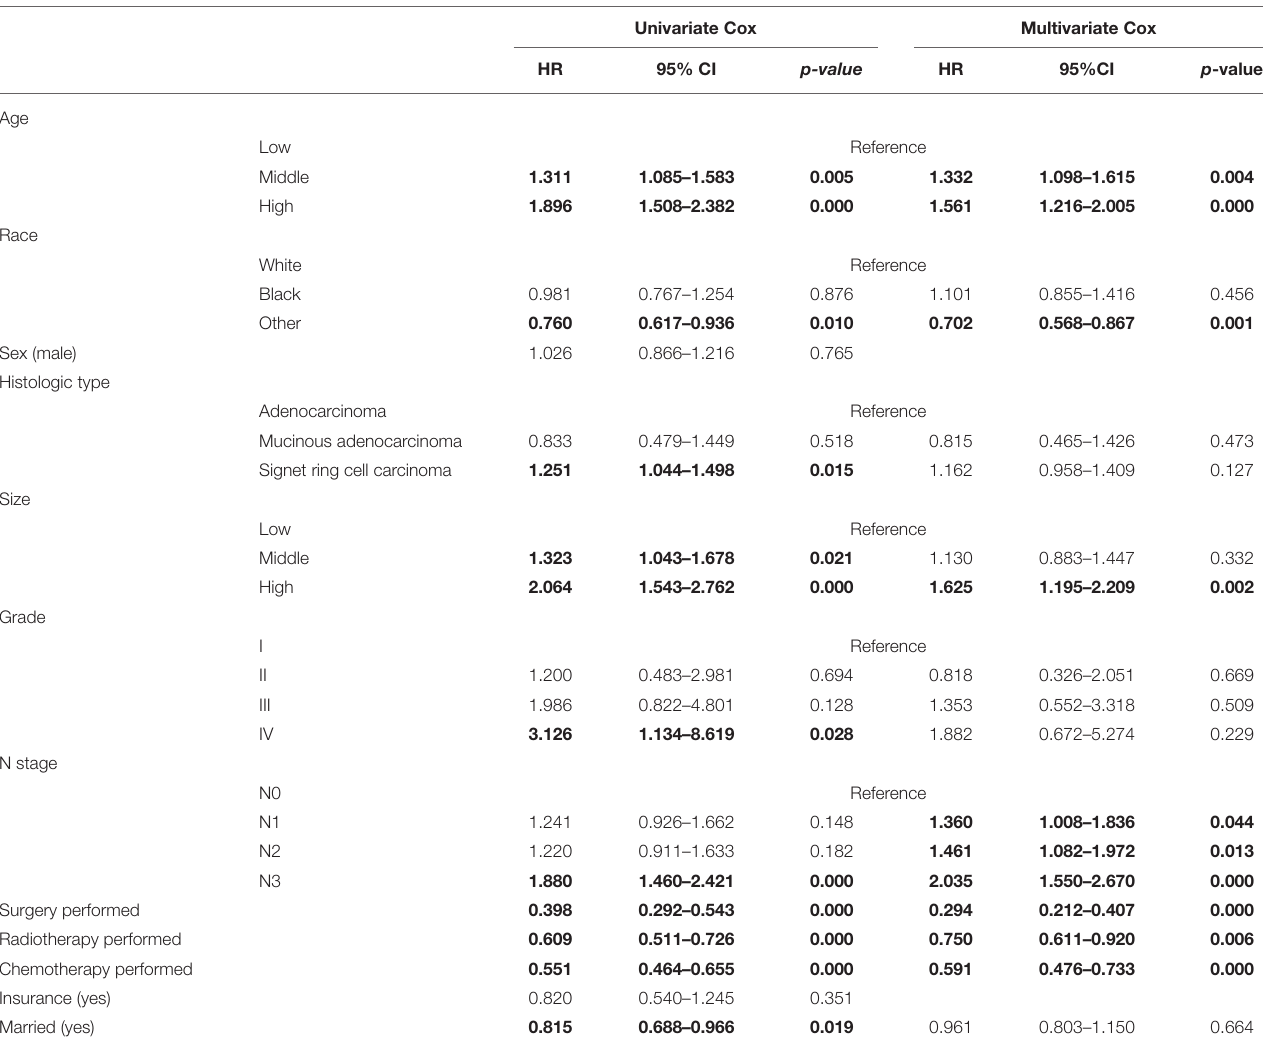
TABLE 3 | Univariate and multivariate Cox analyses for the OS of patients with T4aN0-3M0 GC in the training